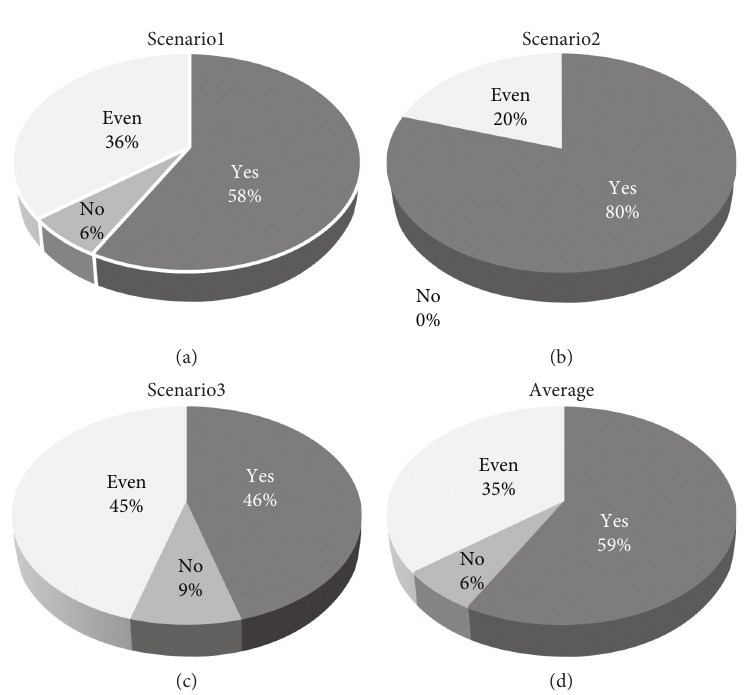
Figure 6: Results for question VI (“even” indicates neutral